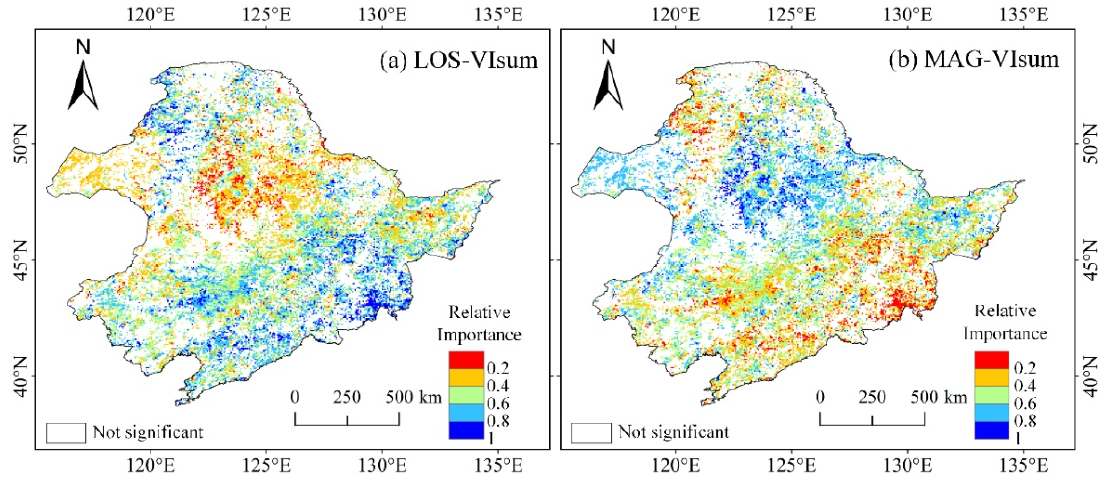
Figure 11. Maps of the relative importance of LOS ( a ) and MAG ( b ) to VIsum derived MODIS EVI